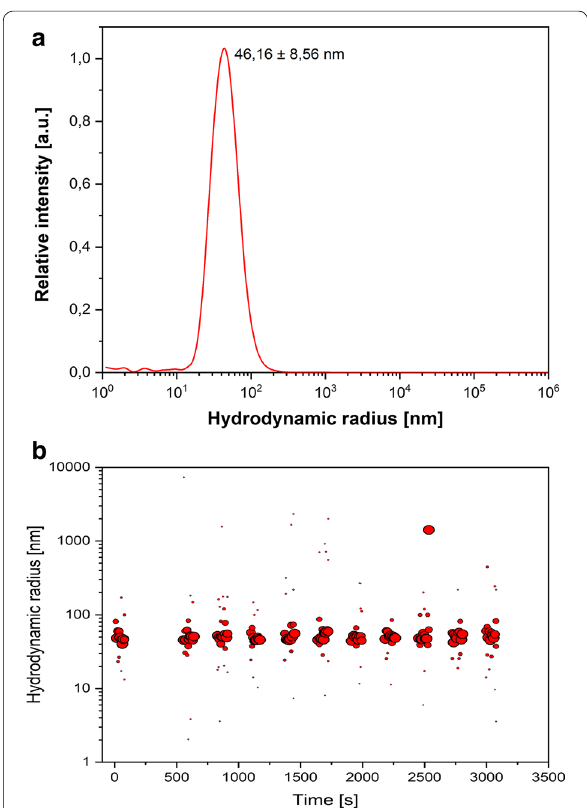
Fig. 5 Dynamic Light Scattering (DLS) measurement of biosynthesized Ag NPs. For the others, see the legends to Fig. 4